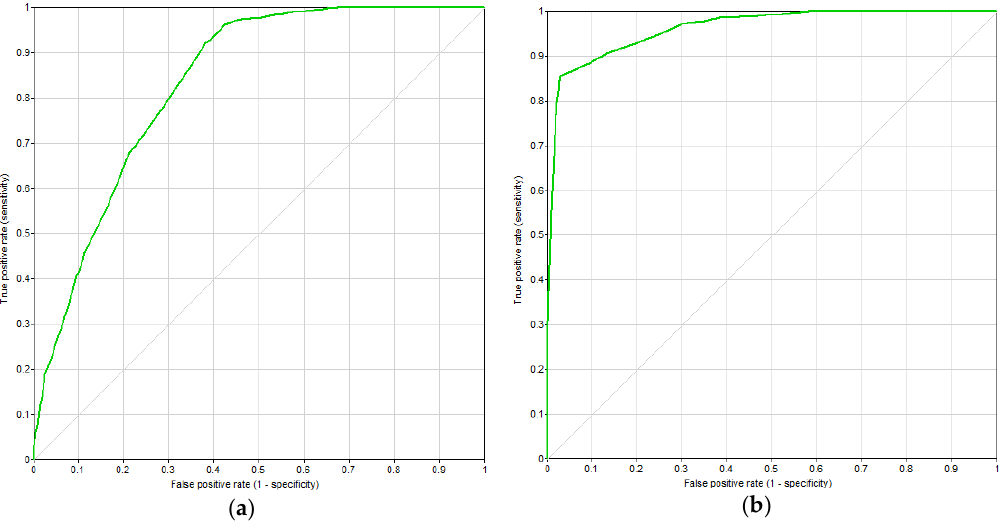
Figure 15. Receiver operating characteristic curves (ROC) curves for predicting ( a ) departure delays between 3 and 15 min and ( b ) departure delays over 15 min.